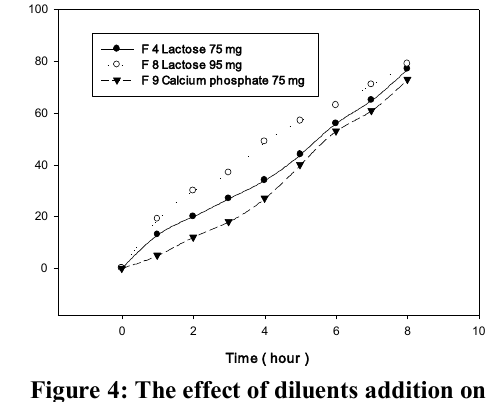
Figure 4: The effect of diluents addition on the release of CBZ from ethyl cellulose.